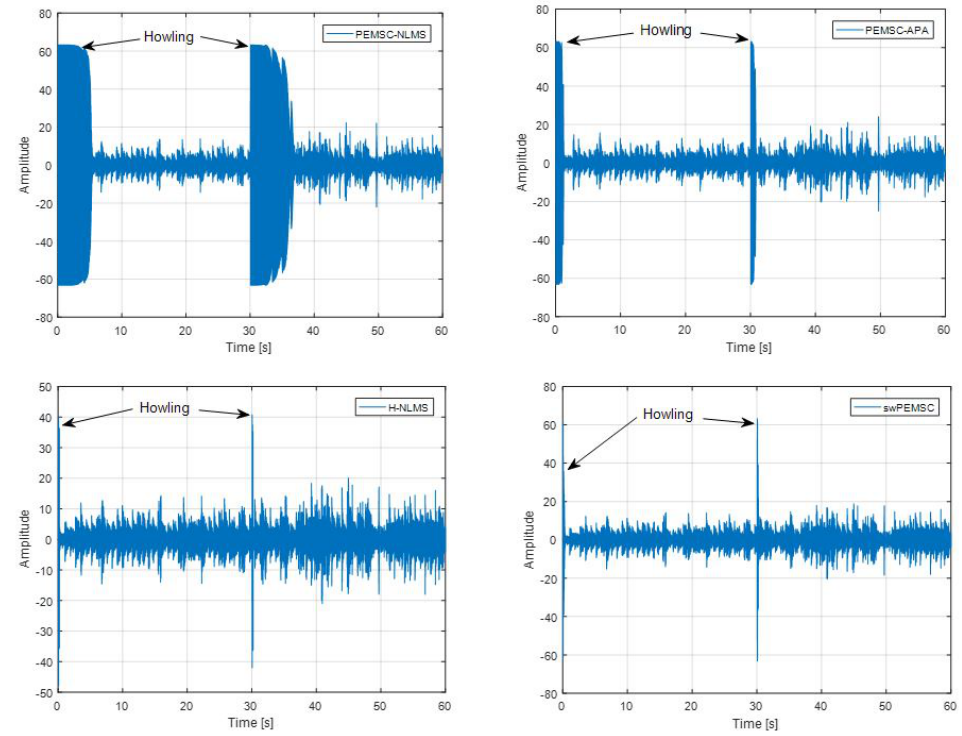
Figure 14. Compare howling periods in output signal of the proposed approach with baselines, music incoming signal, a sudden change of the feedback path from F 1 to F 2 after 30